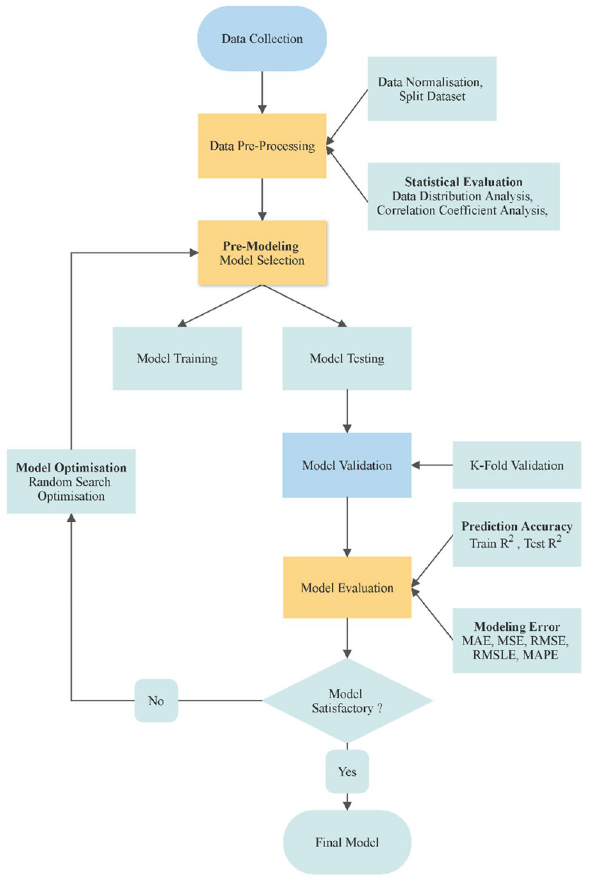
Figure 3. Step by step BML modelling approach.